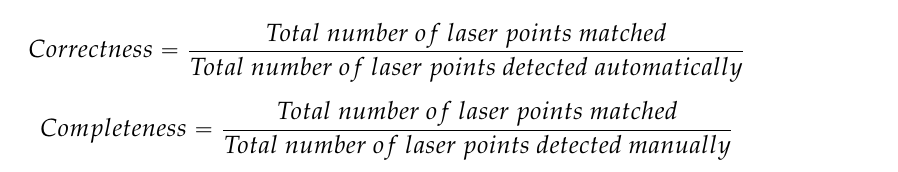
Figure 17. Segmentation results based on the spherical neighborhood definition.